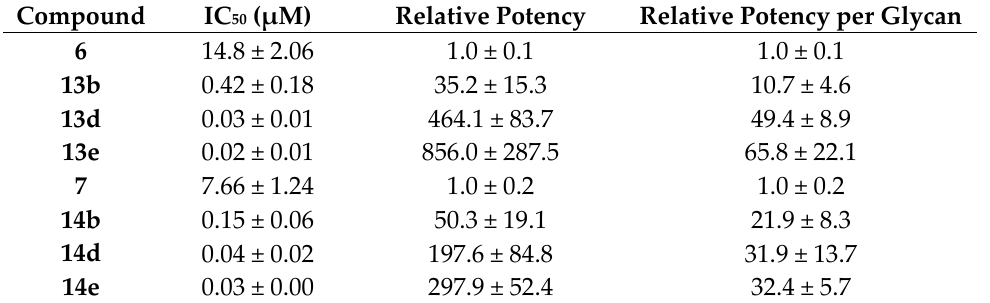
Figure 7. IC 50 values of neo-glycoproteins for Gal-3 inhibition. IC 50 values of selected neo-glycoproteins ( ■ ) and the corresponding free saccharides ( ■ ) are compared. Neo-glycoproteins showed higher inhibitory potential compared to monovalent glycans, as well as with increasing number of glycans per molecule. Calculated IC 50 values are depicted in Table 2. Table 2. Calculated IC 50 values and relative inhibitory potencies of neo-glycoproteins. Values of inhibitory potentials are stated for tested tetrasaccharides and neo-glycoproteins. In the right column, inhibitory potencies were calculated per glycan to identify a possible influence of